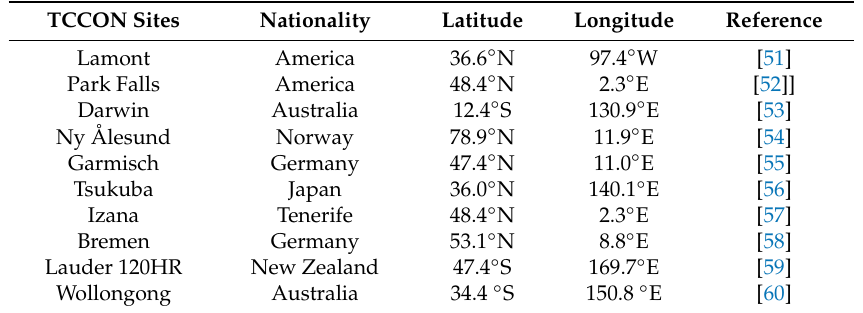
Table 3. Geolocation and reference of each TCCON station used in comparison and validation.